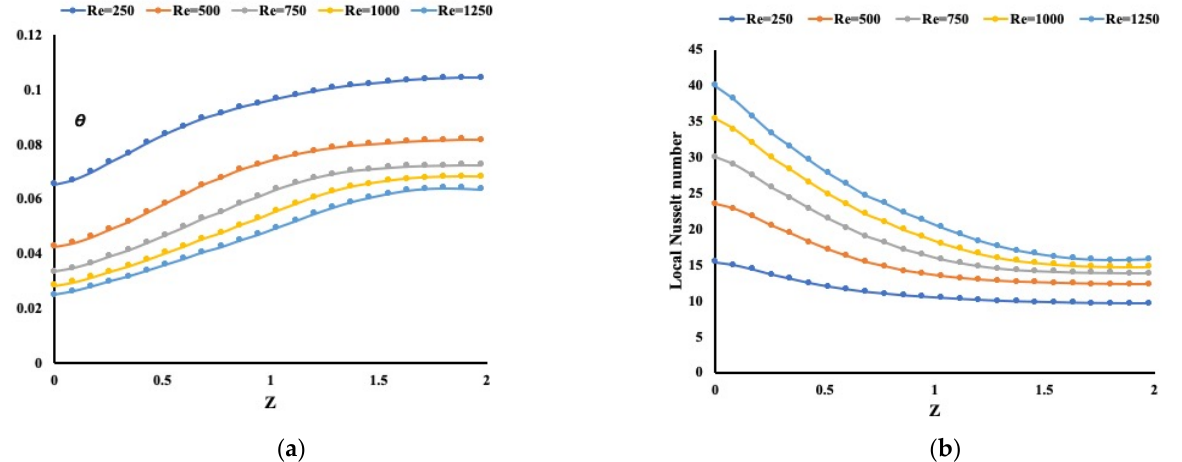
Figure 5. Temperature and local Nusselt number variation in mini-channel configuration (AR = 6). ( a ) Temperature distribution. ( b ) Local Nusselt number variation.